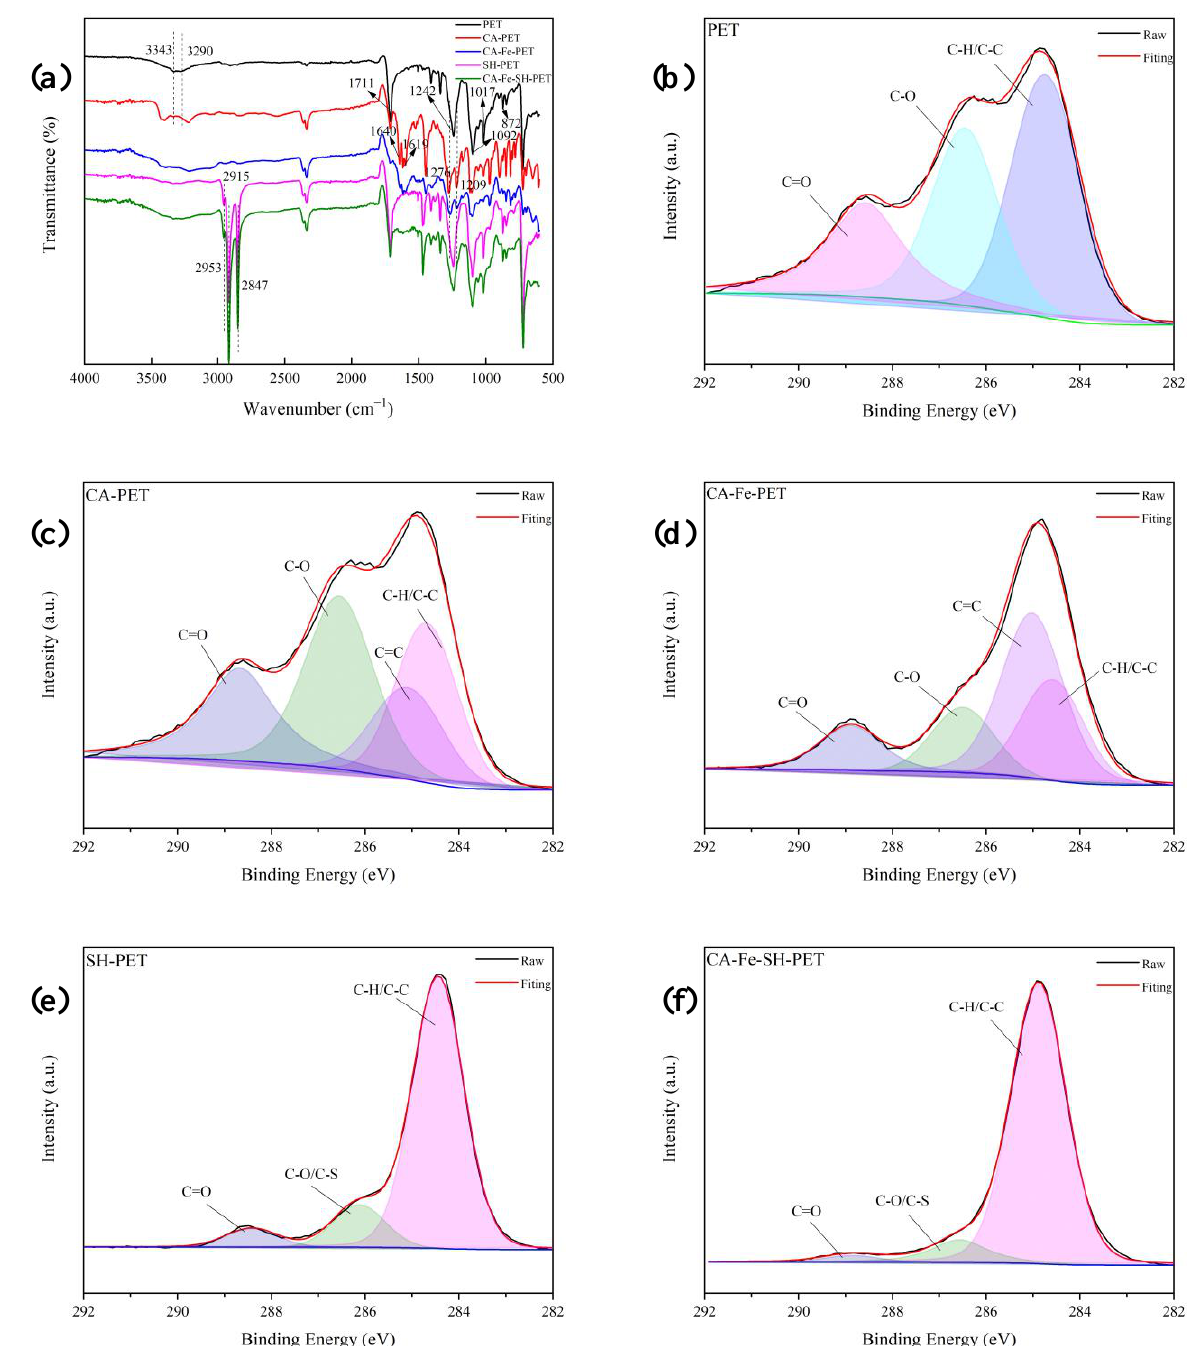
Figure 5. ( a ) ATR spectra of PET, CA-PET, CA-Fe-PET, SH-PET, CA-Fe-SH-PET. ( b ) High-resolution XPS spectra C1 S of PET, ( c ) CA-PET, ( d ) CA-Fe-PET, ( e ) SH-PET, and ( f ) CA-Fe-SH-PET. Figure 5 (b-f) shows the C1s high-resolution spectra of the PET and different modi- fied polyester fabrics. All samples showed the characteristic peaks of C – C/C – H (284.7 ev), C – O (286 ev), and C = O (288.6 ev). C = C (285 ev) appeared in CA-PET and CA-Fe-PET,